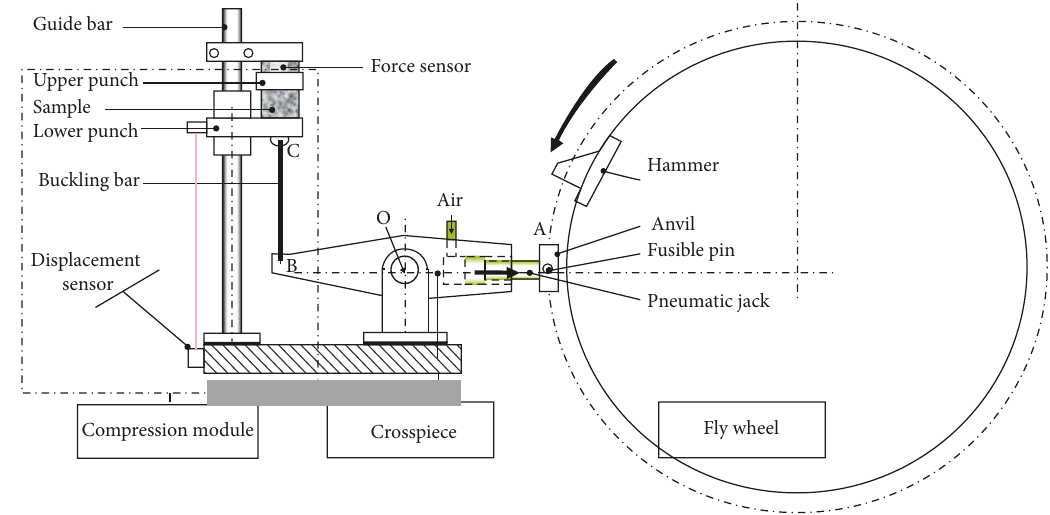
Figure 2: Fly wheel device [31].